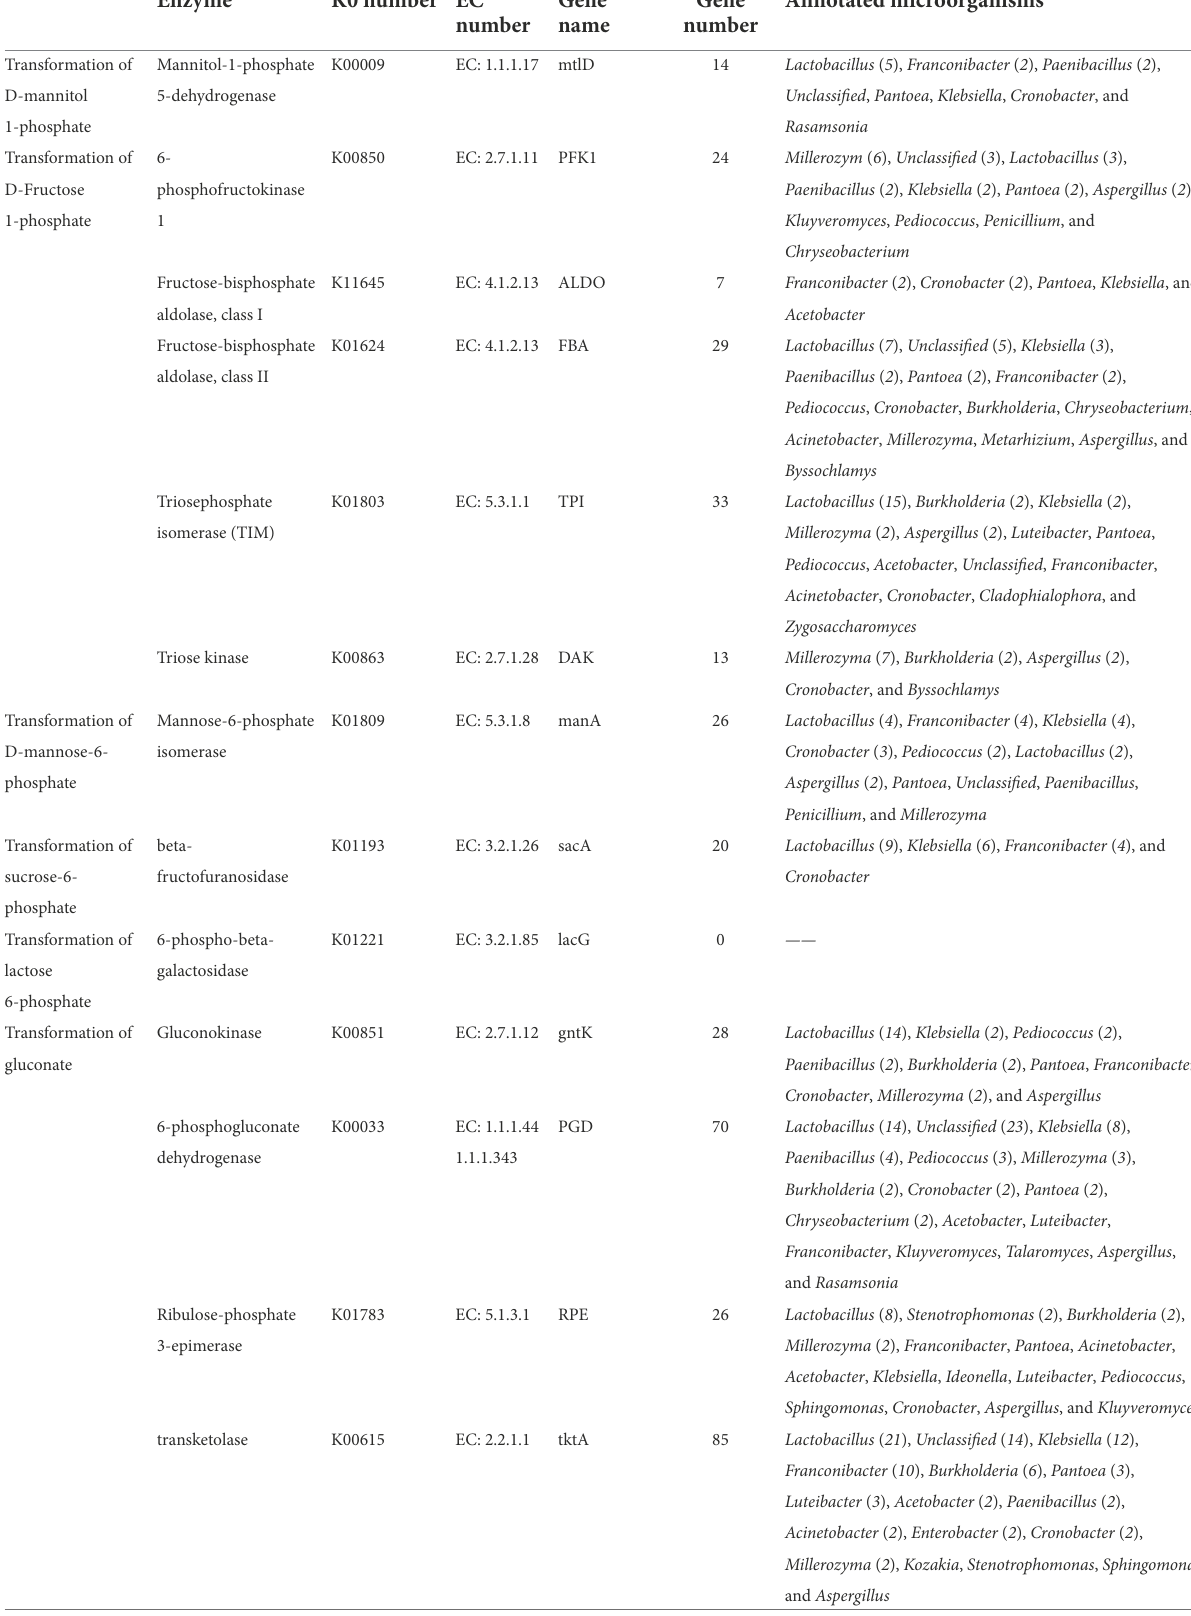
TABLE 2 Genes encoding enzymes involved in conversion sugar into intermediates of glycolysis pathway. Enzyme K0 number EC